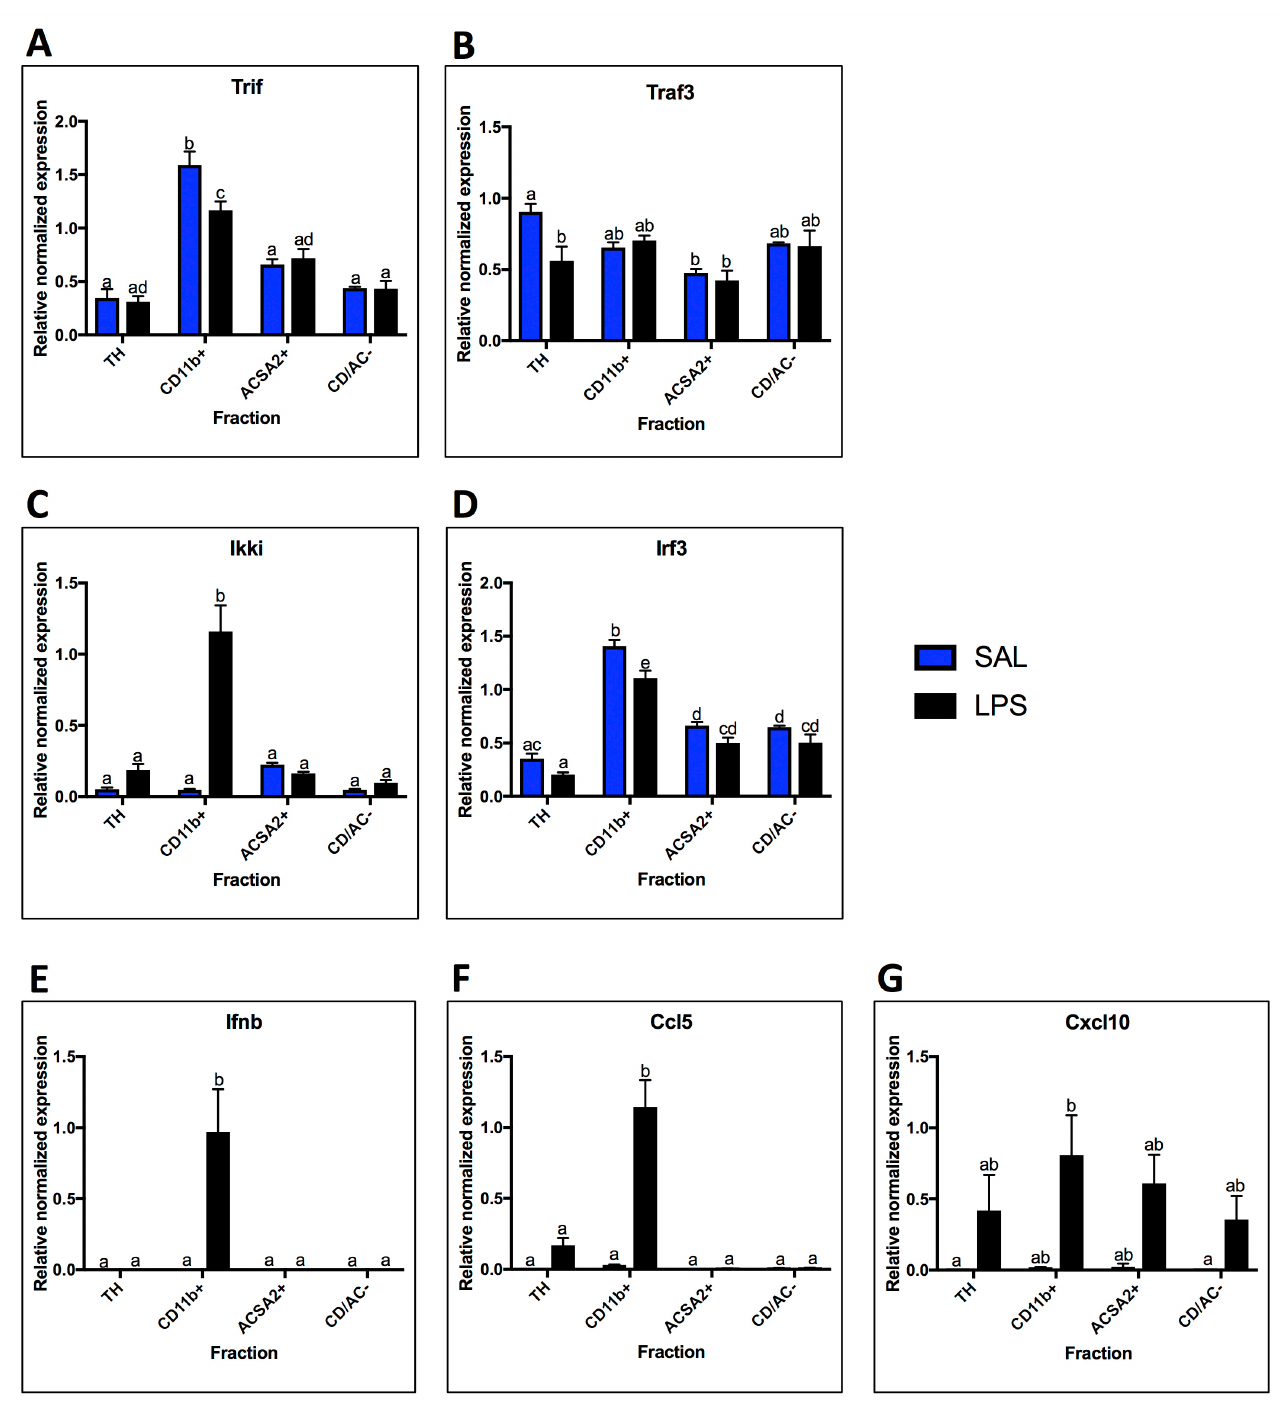
Figure 5. TRIF-dependent pathway mRNA expression. Fraction mRNA localization for components and outputs of the TRIF-Dependent Pathway in saline and LPS treated animals. A. Trif was highest expressed in the microglial fraction with saline and decreased with LPS. B. Traf3 expression was relatively even across the fractions, with only significant difference being between the total homogenate (TH) and the astrocyte fraction. There were no significant changes with LPS. C. Ikki expression was not significantly enriched in any fraction with saline, but was highest in astrocytes. With LPS, expression increased in the microglial fraction. D. Irf3 expression was highest in the microglial fraction, but was also significantly enriched over the TH in the astrocyte fraction and negative fraction. E. Ifnb was not detected in any fractions with saline, but was expressed in microglia with LPS. F. Expression of Ccl5 was expressed in low amounts in microglia with saline, but was detected in the TH with LPS and increased in microglia. G. Cxcl10 was expressed in low levels in the microglial and astrocyte fractions with saline, but was detected in all fractions with LPS, although none of the changes were significant. Two bars with the same letter are not statistically different; two bars with no letter in common are statistically different (two-way ANOVA with Tukey’s test for multiple comparisons, p<0.05). SAL, saline; LPS,